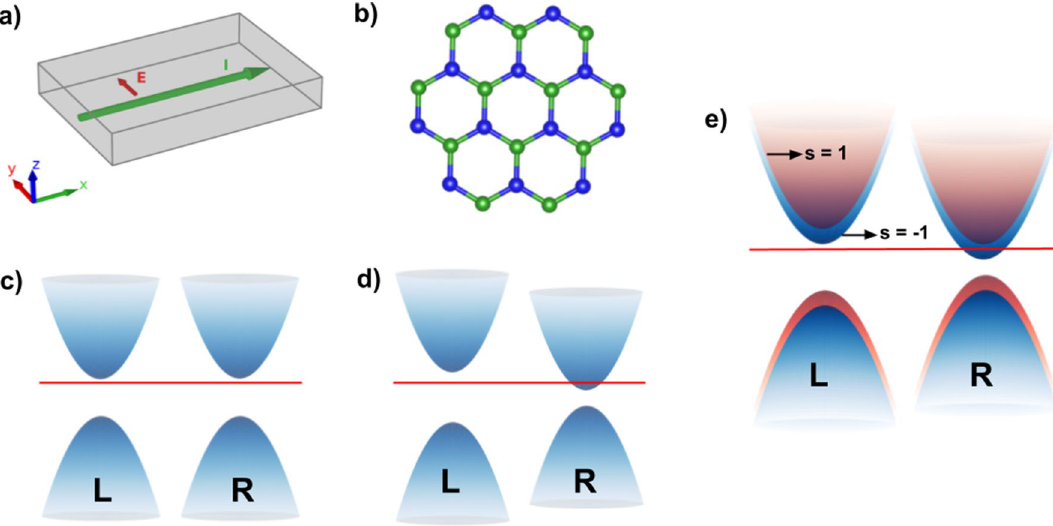
Figure 1. ( a ) The A-QHE generates an electric current perpendicular to the external electric field; ( b ) honeycomb lattice with broken sublattice symmetry; ( c ) dirac cones with simple gap, analogous to the chirally symmetric case; ( d ) valley asymmetry corresponding to imbalance in chirality; ( e ) schematic representation of the band structure when a spin split is present besides valley